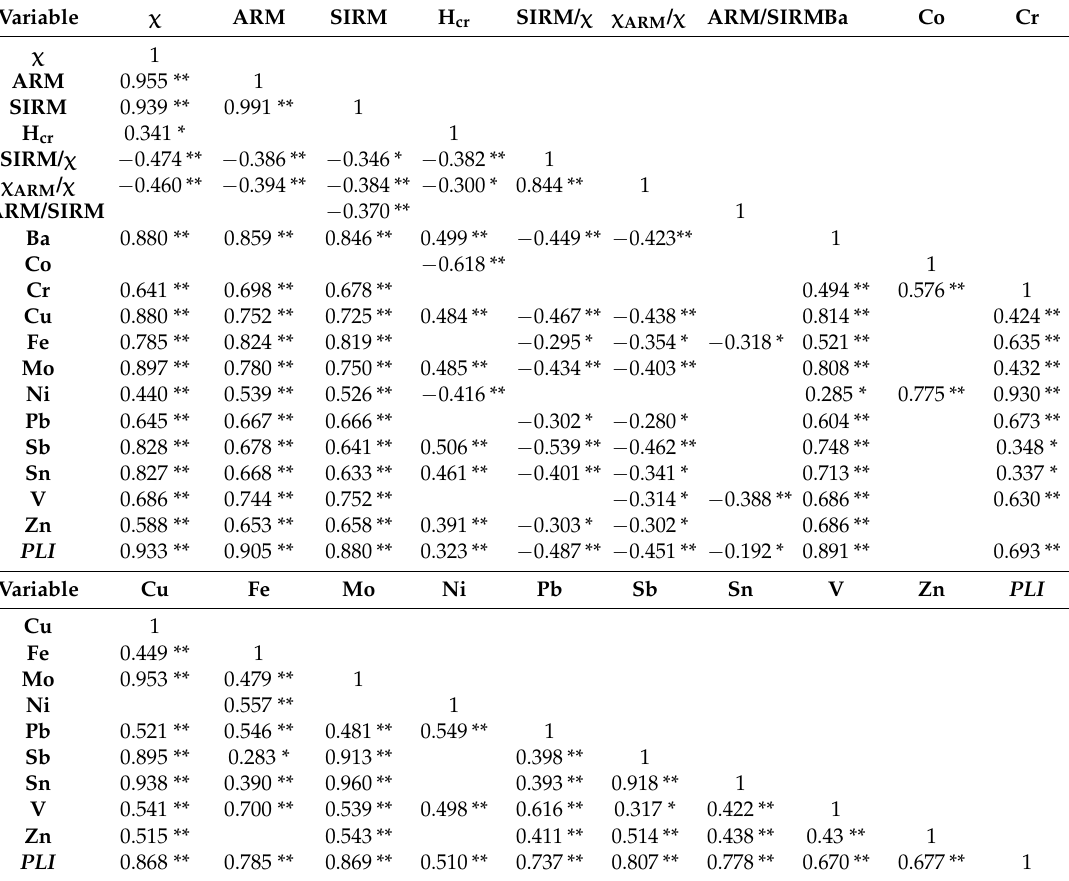
Table 2. Pearson’s coefficients (R-values) for correlations between magnetic and chemical variables from T. recurvata samples AMVA ( n =